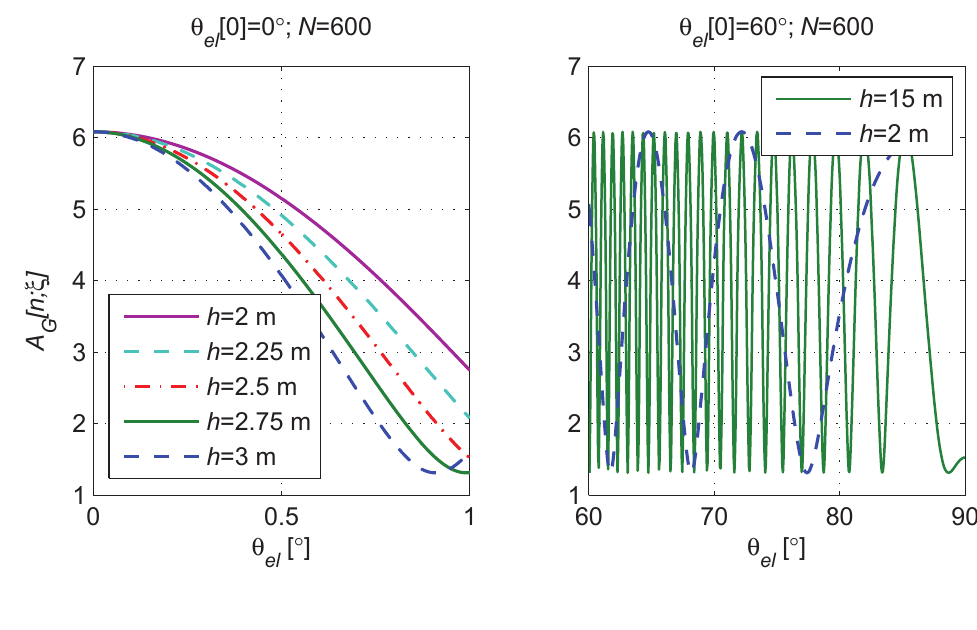
Figure 5. Examples of A evolution for different receiver heights, in the absence of noise: G ( Left ) A for different elevation angle variations and receiver heights; ( Right ) A G elevation angle variations between 60 ◦ and 90 ◦ and receiver heights of 2 m and 15